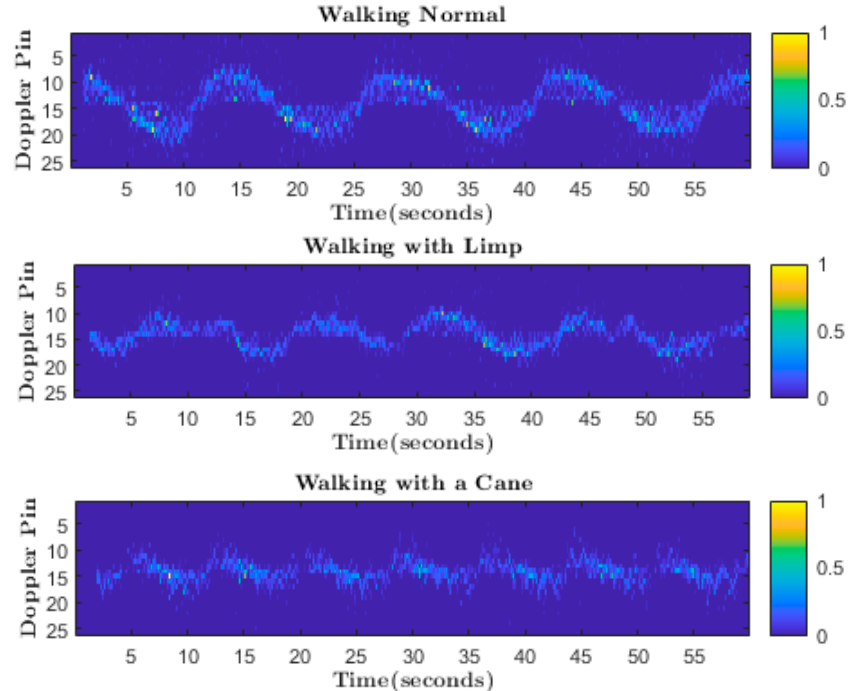
Figure 4. Micro-Doppler signature of different activities.